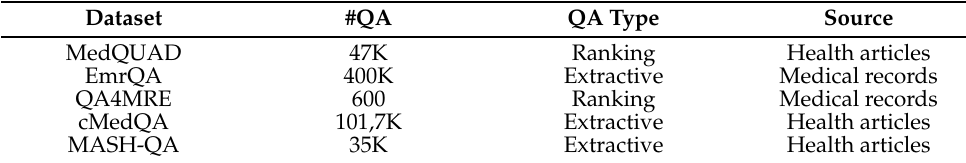
Table 4. Comparison of different healthcare QA